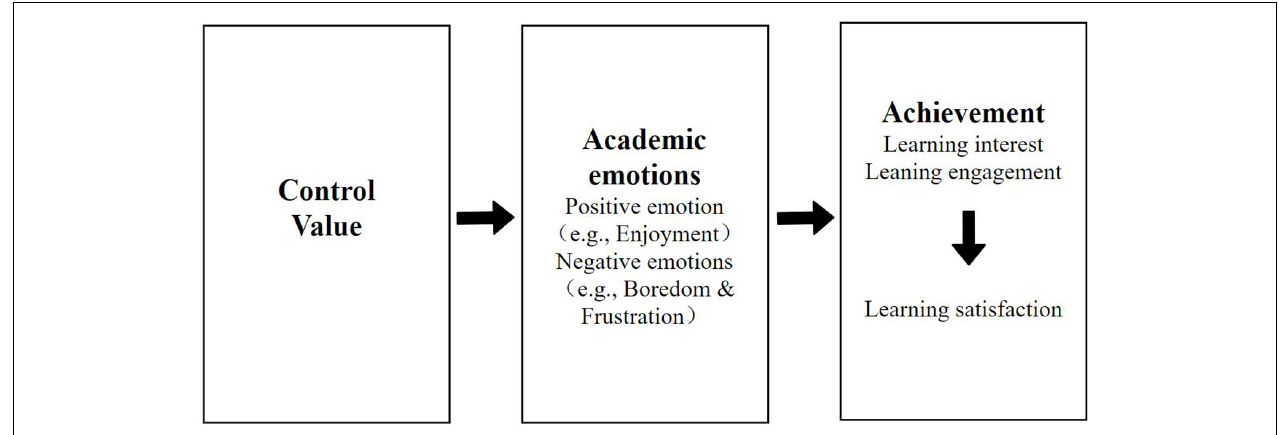
FIGURE 1 | Control-value theory (Pekrun, 2006). A solid arrow shows the direction of the